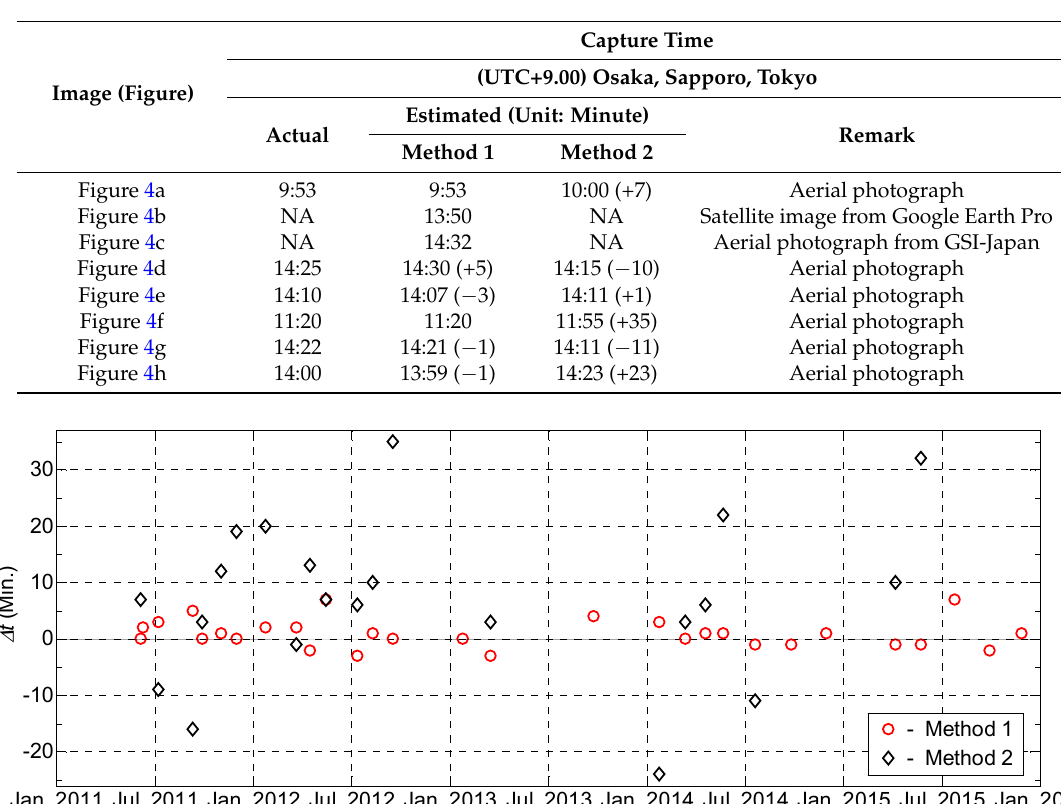
Table 3. Actual capture times and estimated capture times of images.